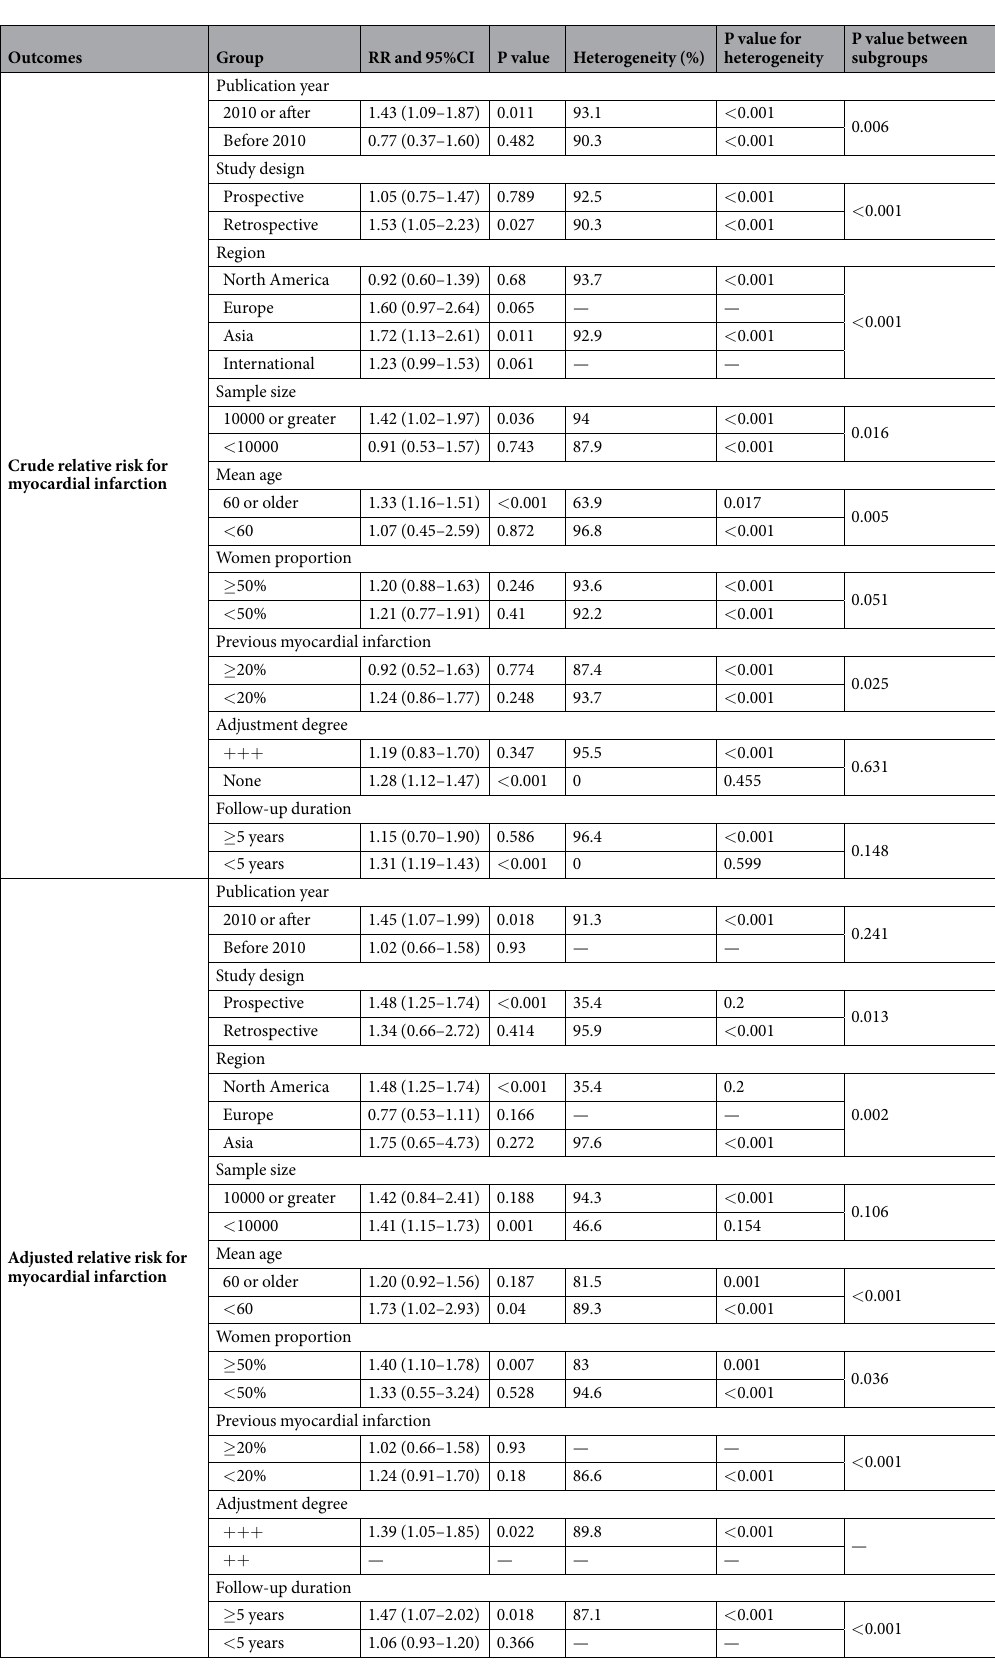
Table 3. Subgroup analyses of crude relative risk for myocardial infarction and adjusted relative risk for myocardial